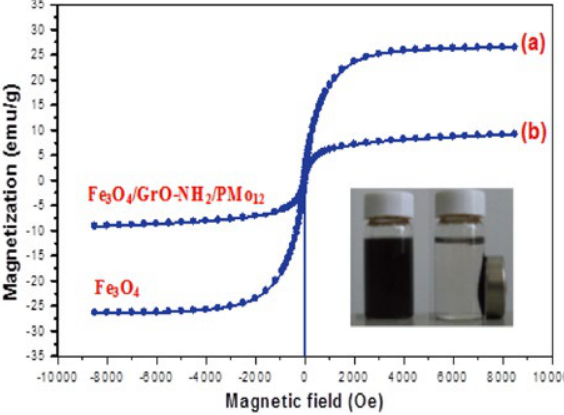
Figure 8. Magnetic hysteresis loop of (a) Fe NH /H PMo O at room temperature. The inset shows the behav- 2 3 12 40 iour of the nanocomposite under an external magnetic